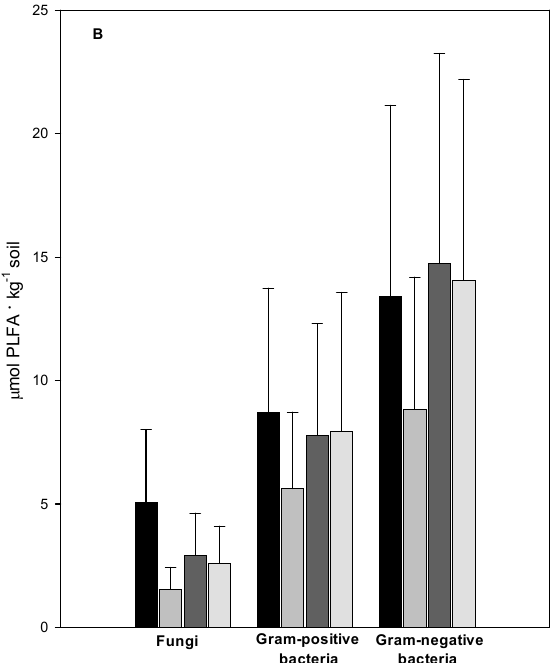
Figure 2. Mean microbial biomass in the forest floor ( A ) and mineral soil (0–5 cm; B ) sampled 1-year post fuel reduction treatments at the Southwestern Plateau, Fire and Fire Surrogate study. Microbial biomass of different functional groups (mean + SE; n = 3) was determined using phospholipid fatty acid analysis (PLFA). Different letters for a given sampling date indicate significant differences ( α = 0.05) using Tukey-Kramer pairwise comparison, generalized linear mixed model analysis of treatments. When no letters are provided, mean values among treatments were similar statistically.